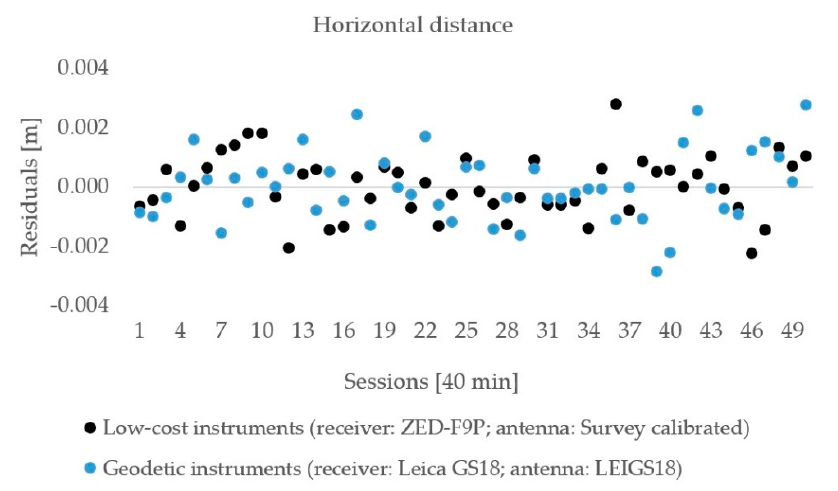
Figure 9. The horizontal distance residuals for geodetic and low–cost GNSS instruments.